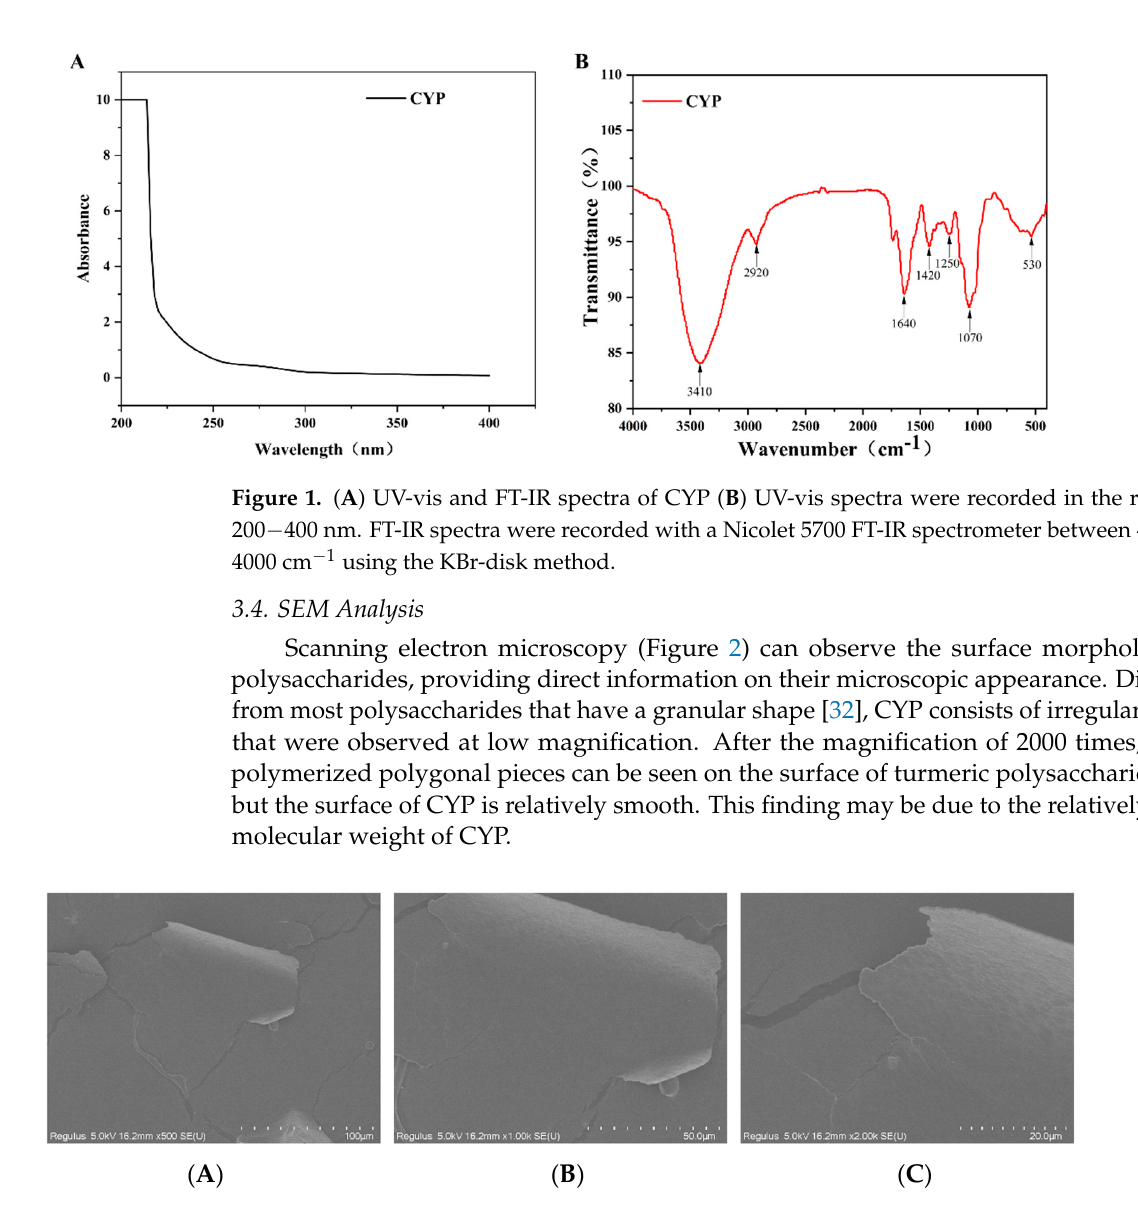
Figure 2. SEM micrographs showing surface microstructure of CYP (( A – C ), 500×, 1000×, 2000× respectively).